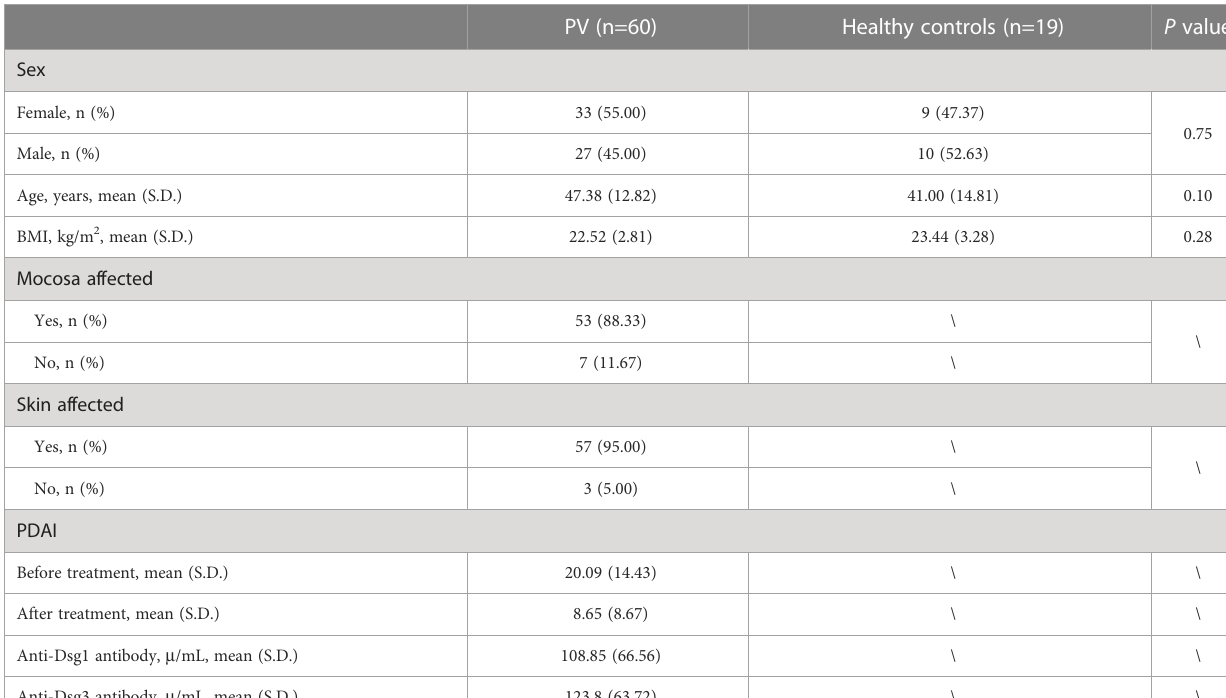
TABLE 1 Demographic and clinical information of patients with PV and healthy